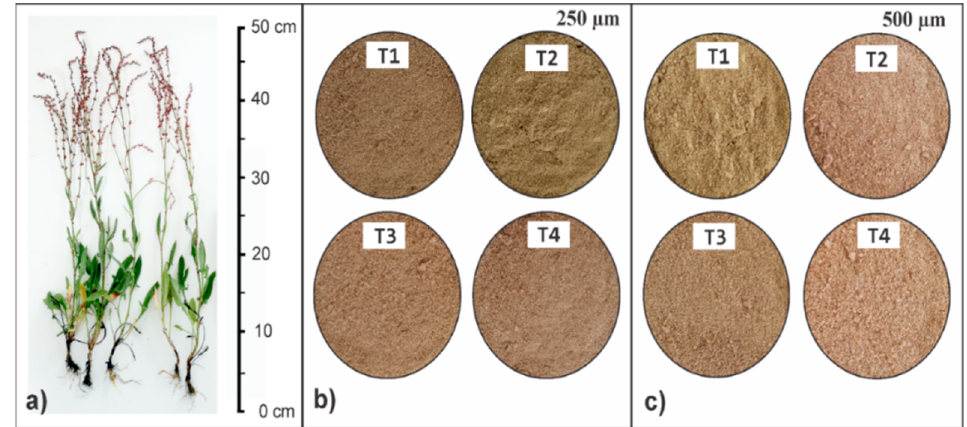
Figure 2. Plant material ( a ) and modified biosorbents from R. acetosella 250 µm ( b ) and 500 µm ( c ).